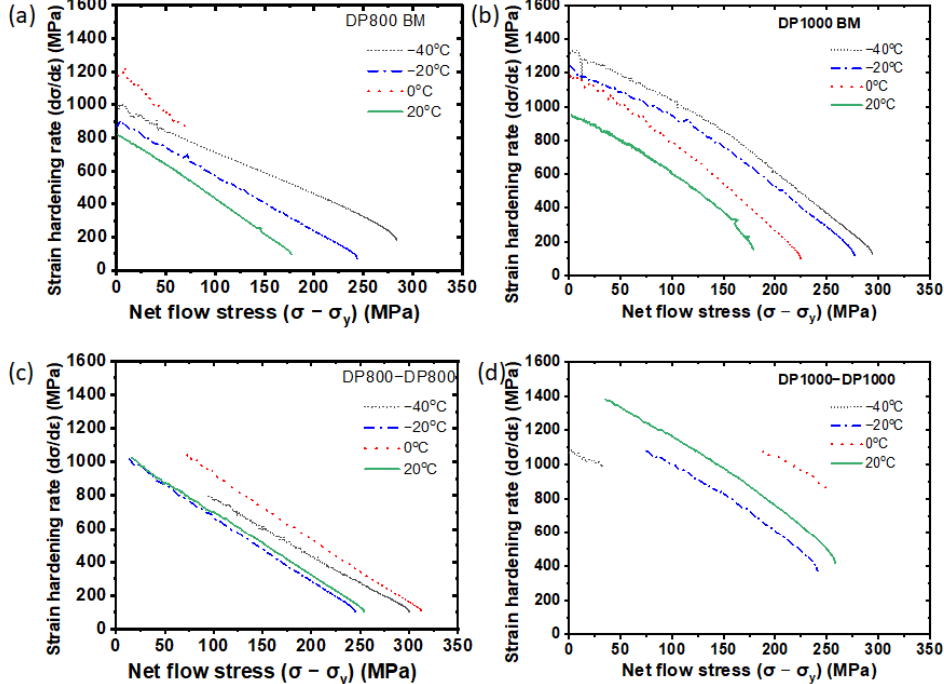
Figure 11. Strain hardening rate as a function of net flow stress for ( a ) DP800, ( b ) DP1000 BM, ( c ) DP800 welds, and ( d ) DP 1000 welds, at different deformation temperatures from 20 °C to −40 °C .